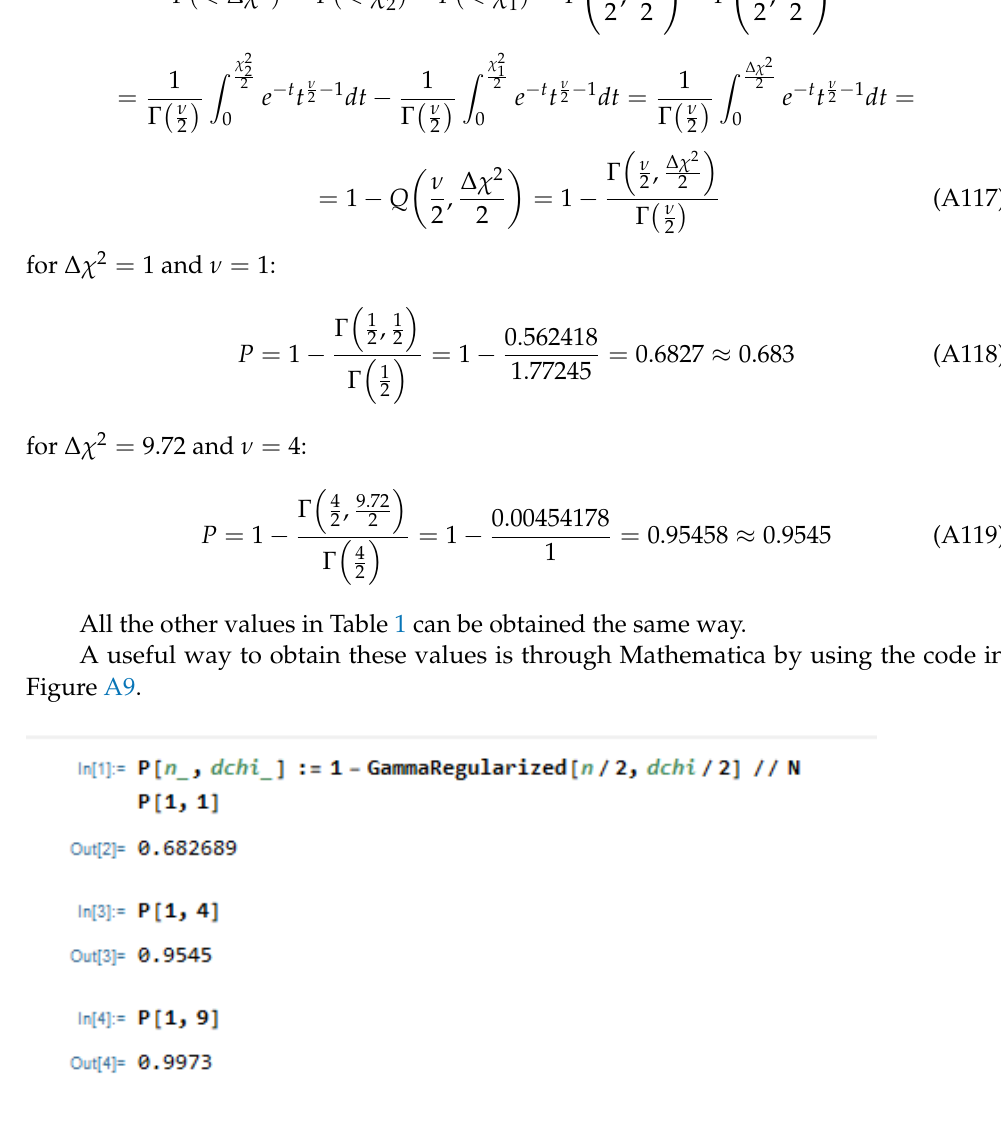
Figure A9. Mathematica code for the derivation of Table 1, where n is the number of degrees of freedom and dchi is the value of ∆ χ 2